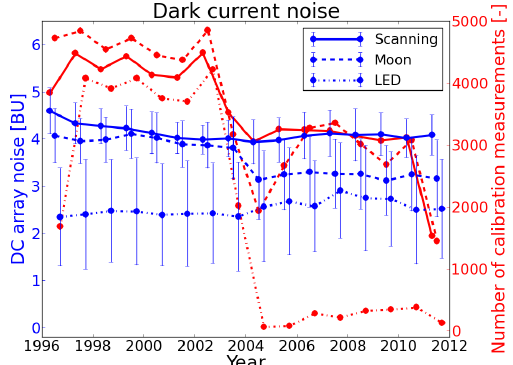
Figure 16. Annual mean PMD noise (blue curves, left y axis) in bi- nary units (BU) for three integration time patterns: scanning (solid curve), moon (dashed curve), and LED (dotted–dashed curve). Red curves (right y axis) denote the number of available calibration mea- surements for the three individual time